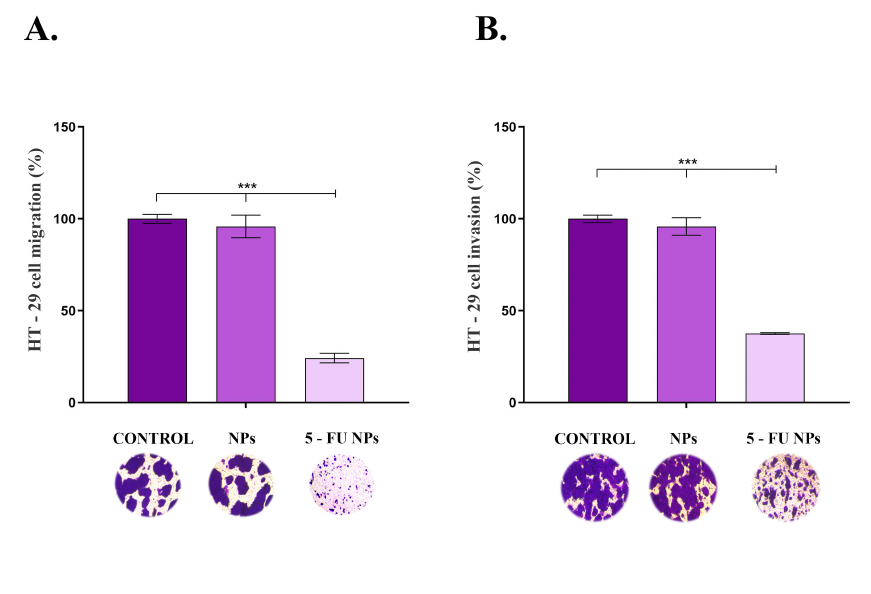
Figure 6. HT–29 ( A ). cell migration and ( B ). invasion potential after 48 h of exposure to pristine and 5-FU loaded PEGylated SF NPs as revealed by transwell-based assays (*** p ≤ 0.001). Representative optical microscopy images of HT–29 Crystal Violet-stained cells are shown below each